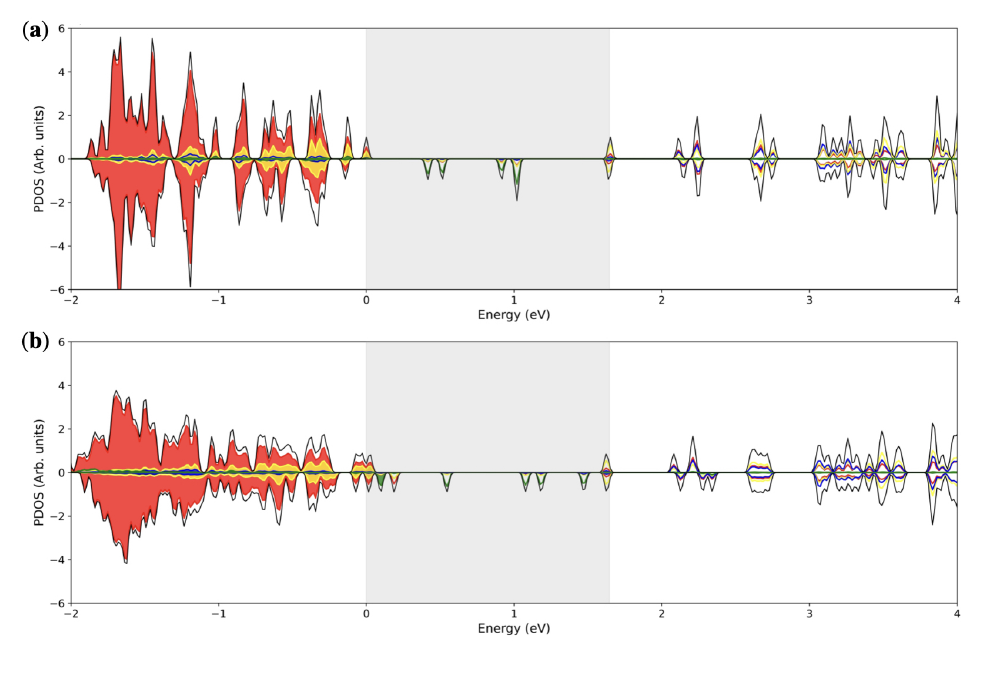
Figure 3. PDOS for configurations ( a ) α 1 and ( b ) β 1 (copper = red, sulfur = yellow, aluminium = blue and iron =